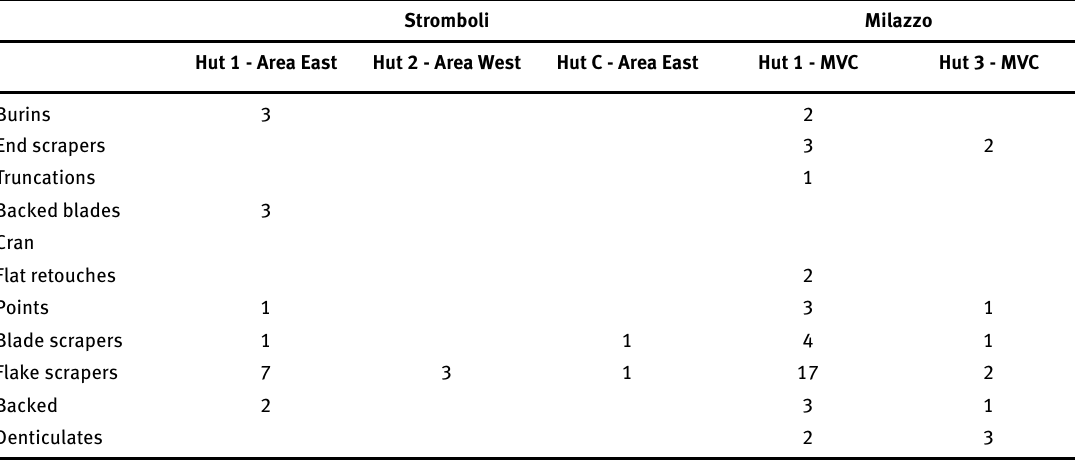
Table 3. Obsidian tools in Bronze Age huts at San Vincenzo and at Milazzo Viale dei Cipressi -